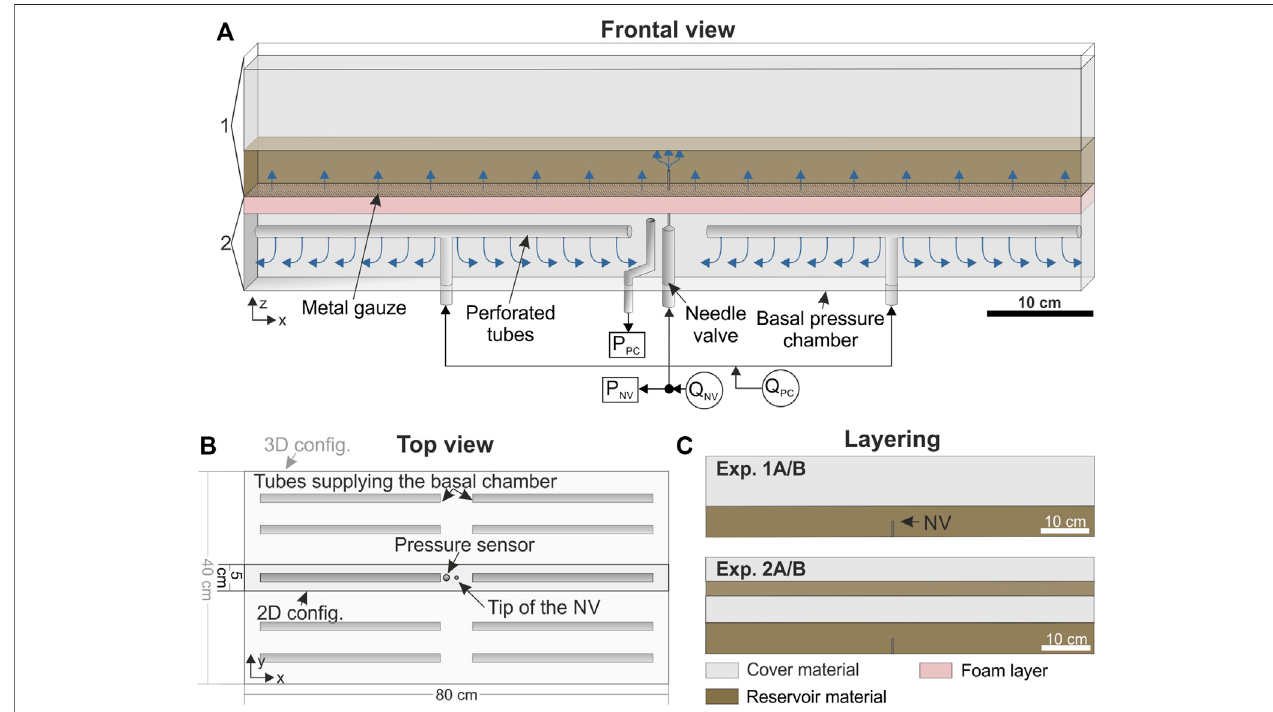
FIGURE 2 | (A) Sketch of the experimental setup illustrating the upper experimental box (dimensions: 80×5×60 cm) and the lower pressure chamber (modi fi ed from Warsitzka et al., 2019). Ahighly permeable foam layer and a fi ne metal gauze separates both parts of the box and lead tohomogeneously distributed air fl ow at the base of the analog materials. Blue arrows demonstrate air fl ow. (B) Top view of the basal pressure chamber. The width of the experimental box and the basal pressure chamber can be changed from a 5 cm wide 2D con fi guration to a 40 cm wide 3D con fi guration. (C) Layering of analog materials in the experiments with a single- layer cover (experiments 1A and 1B) and with multi-layer cover (experiments 2A and